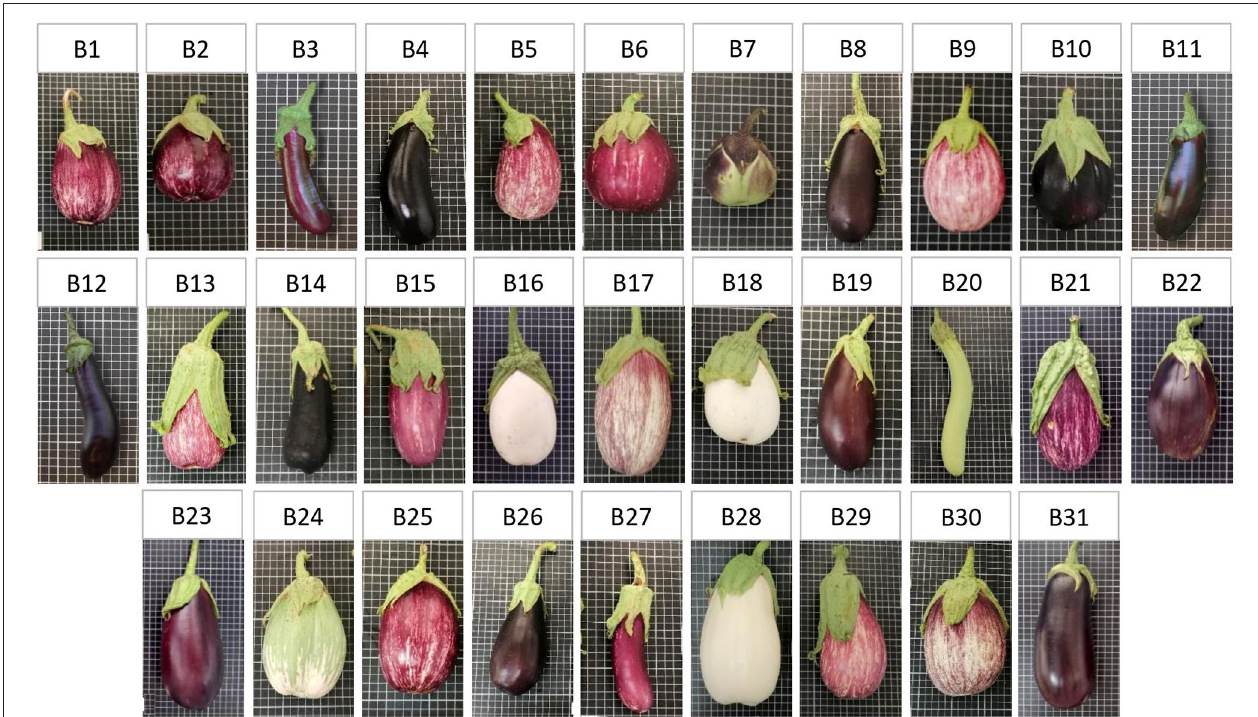
FIGURE 1 | Pictures of the 31 cultivated eggplant landraces ( S. melongena L.) provided by the Germplasm Banks from the COMAV and the IVIA (Spain). The size of the grid cells in the fruit pictures is 1 × 1cm.